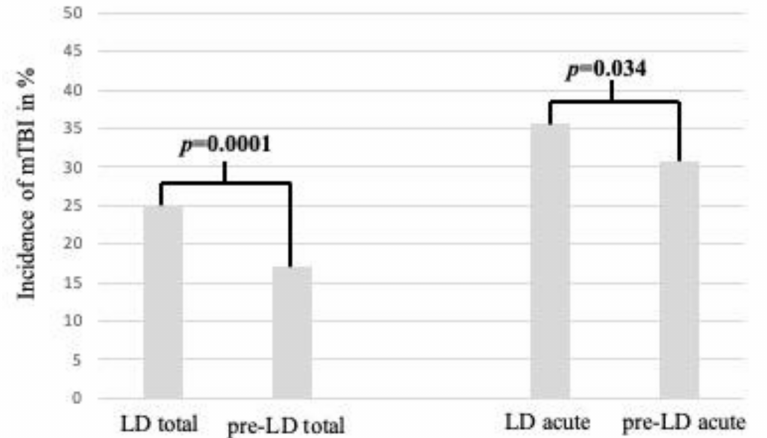
Figure 3. Comparison of mTBIs in % during the LD and pre-LD periods. “LD total” and “pre-LD total” include the total numbers of injuries, and “LD acute” and “pre-LD acute” include only the acute injuries (fractures, mTBIs, wounds and miscellaneous